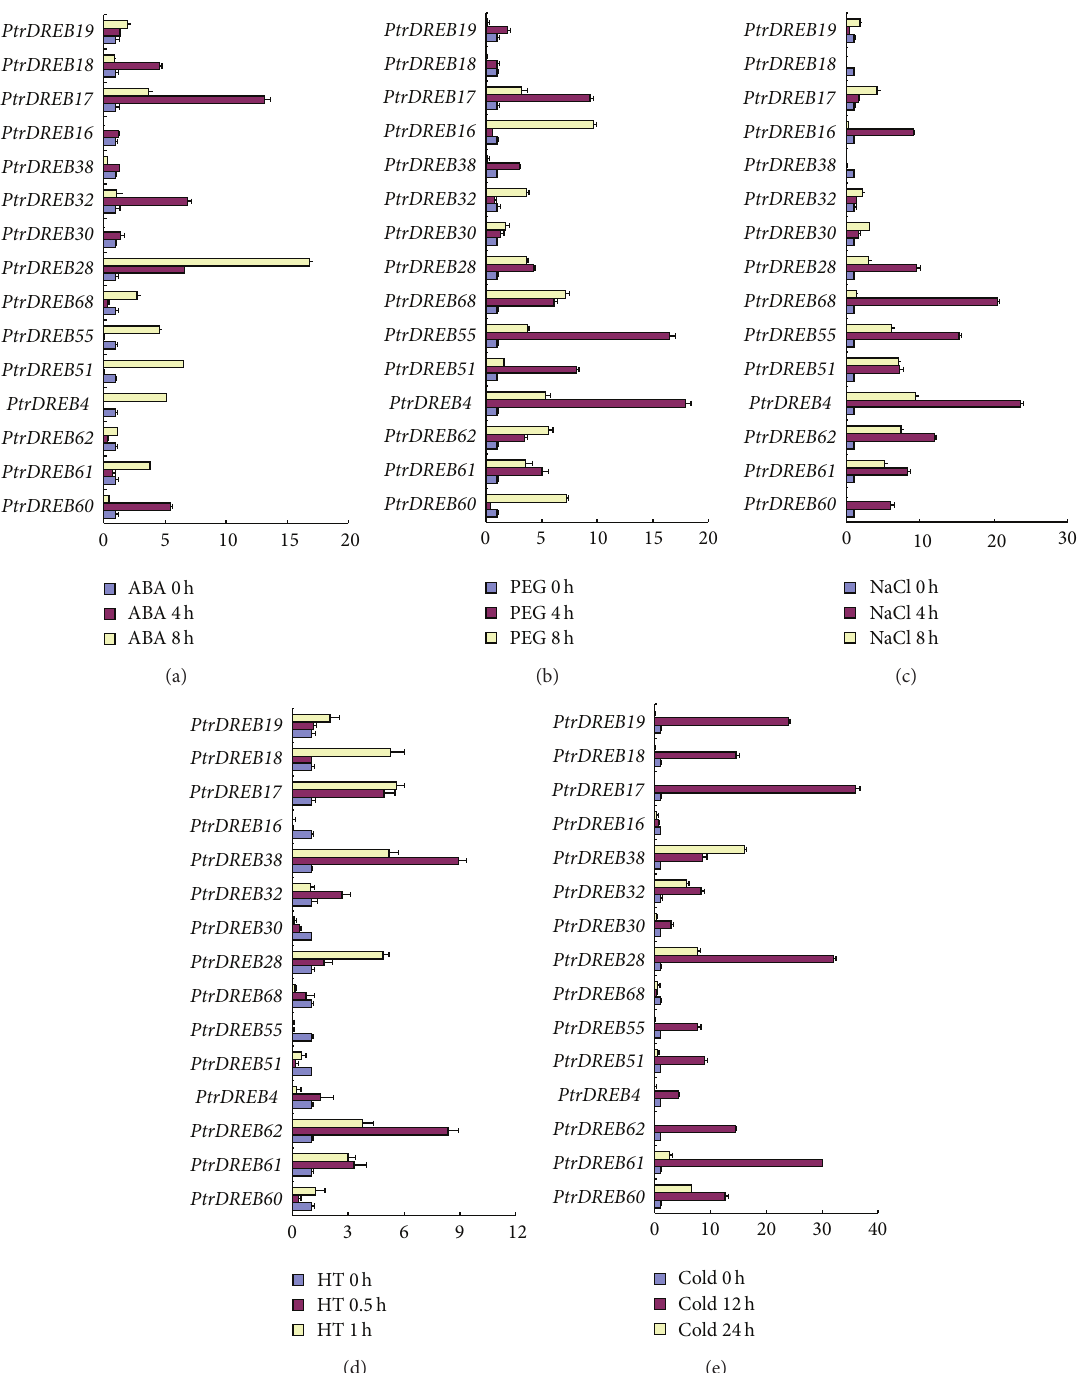
Figure 7: Expression analysis of fifteen selected P. trichocarpa DREB genes in mature leaves under ABA (a), drought stresses (b), salinity (c), high temperature (d), and low temperature (e) by qRT-PCR. The data were normalized using the P. trichocarpa actin gene. Standard deviations were derived from three replicates of each